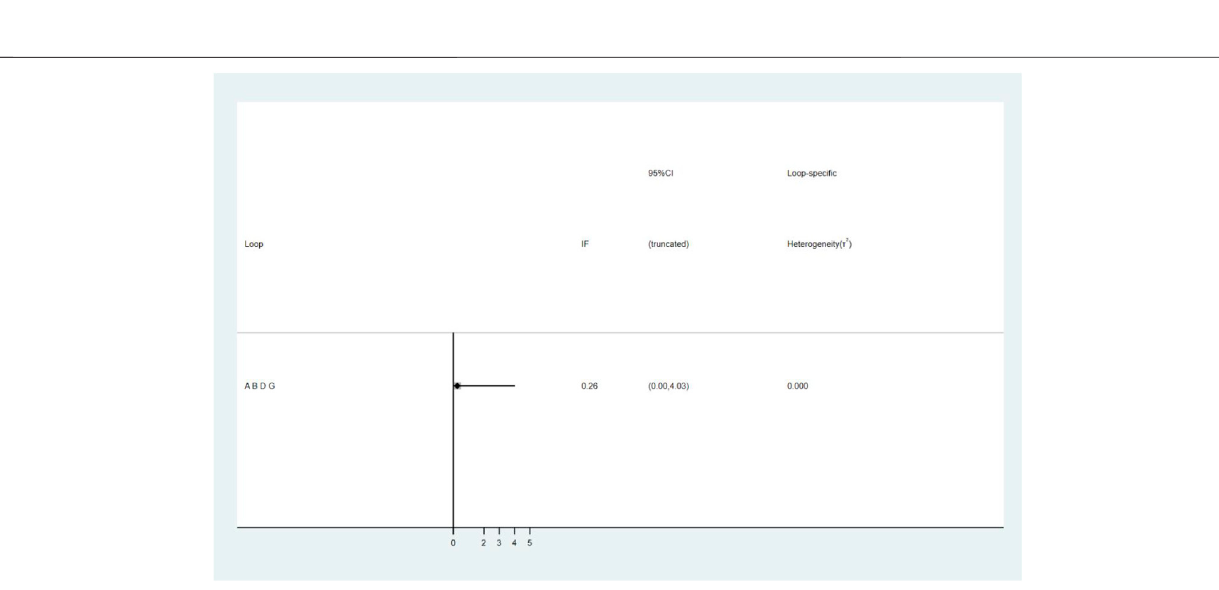
Frontiers in Pharmacology |